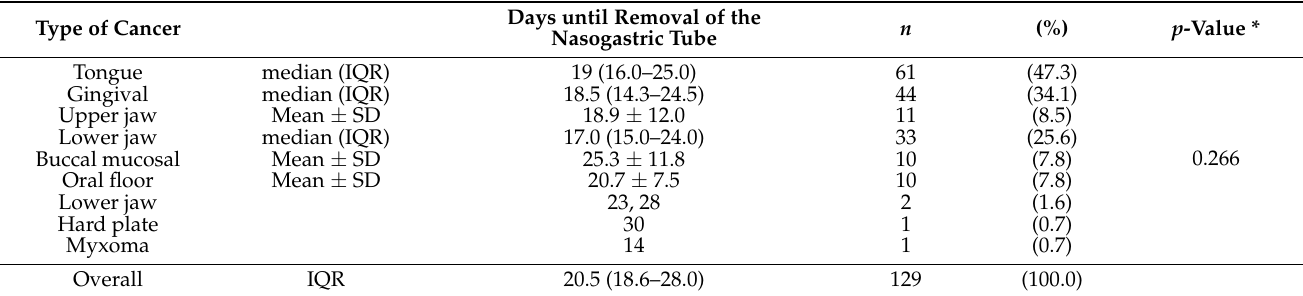
Table 2. Days until removal of the nasogastric tube according to the type of cancer.